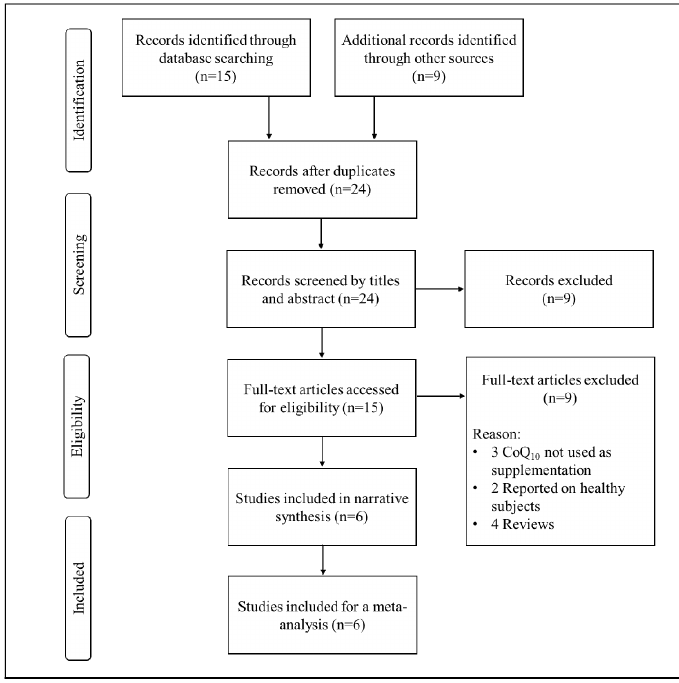
Figure 1. An overview of flow diagram of included studies.